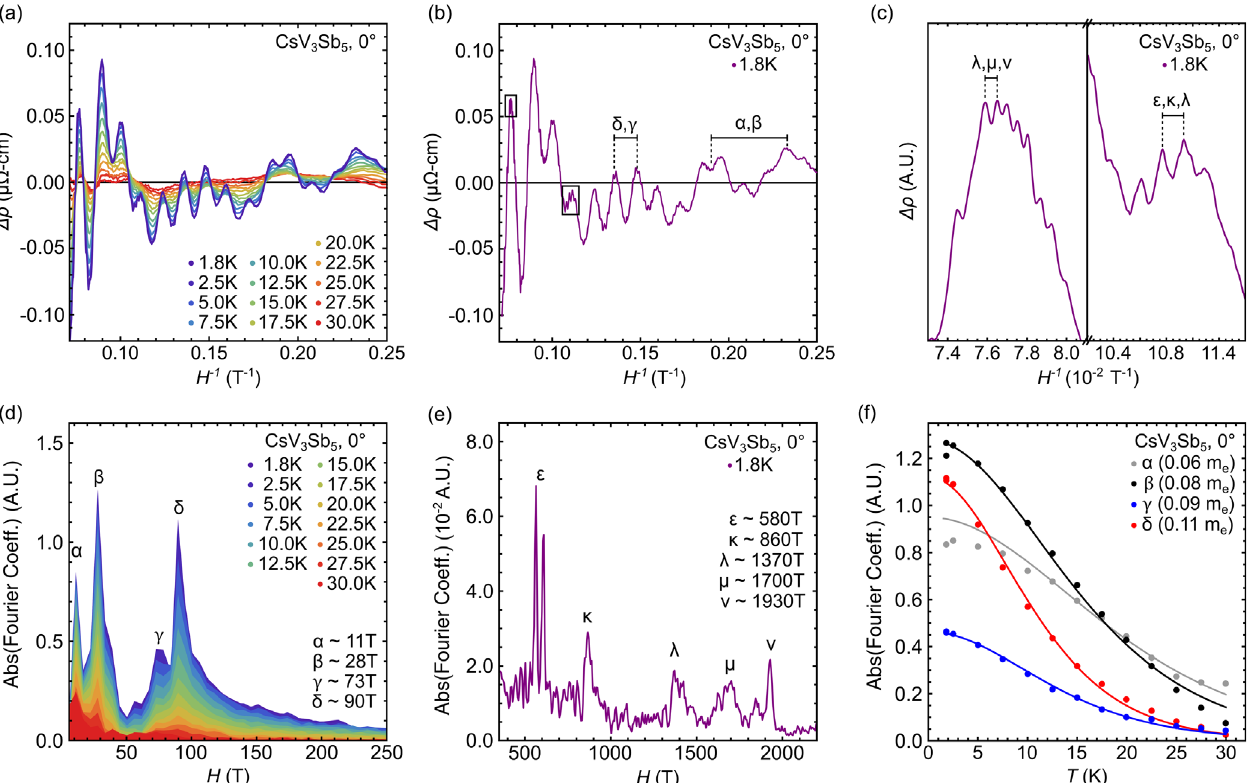
FIG. 5. (a) Oscillatory component of the magnetoresistance extracted from the temperature-dependent SdH data collected on single crystals of CsV 3 Sb 5 mounted with the c axis parallel to the magnetic field (0°). (b) A high-resolution scan at 1.8 K shows significant contributions from high-frequency modes, particularly at the peaks and troughs of the general oscillatory behavior. (c) Magnified view of the high-frequency features, providing visual confirmation for multiple high-frequency modes. (d,e) Fourier transformation of the quantum oscillation data, showing the low- and high-frequency components of the power spectrum. The nine unique frequencies have been assigned greek letters. (f) Temperature dependence of the Fourier coefficients is used in conjunction with the Lifshitz-Kosevich (LK) formula to extract the cyclotron “ effective masses. ” All low-frequency modes show very low effective masses, consistent with transport originating from the Dirac-like crossings at